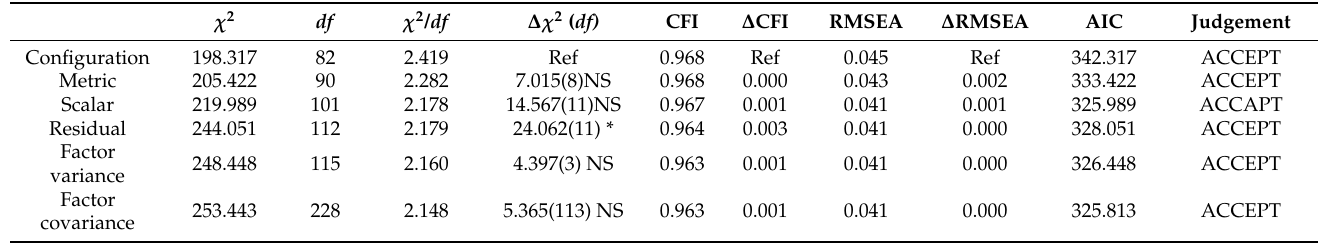
Table 5. Configuration, measurement, and structural invariances of the 3-factor model between nulliparae ( n = 512) and multiparae ( n = 185).